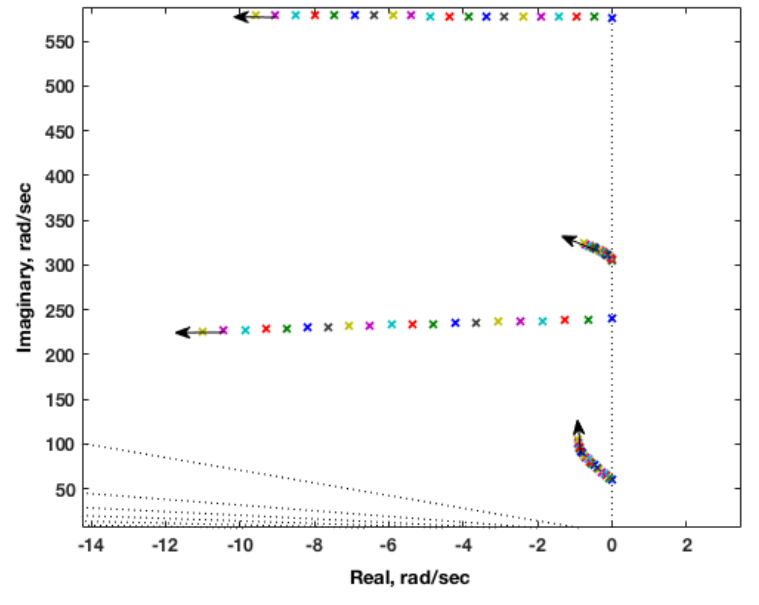
Figure 21. Viscous ROM root locus plot at M =